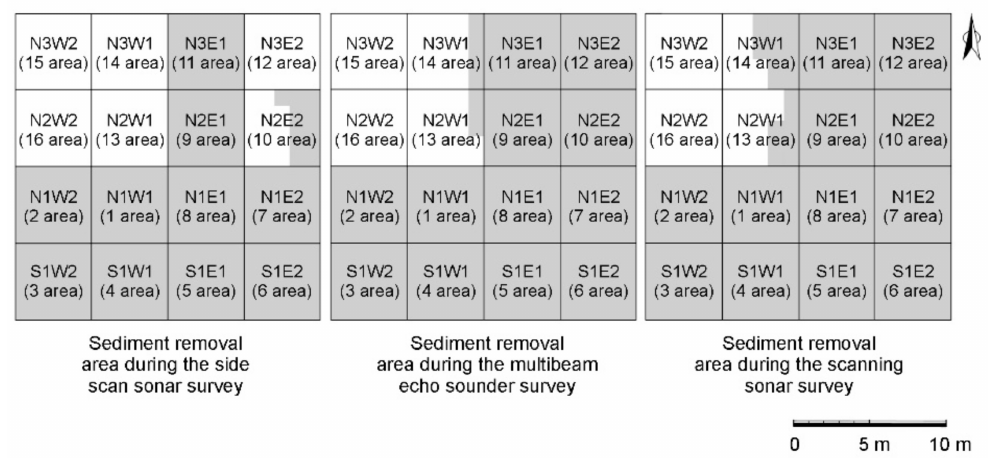
Figure 2. Map codes indicating the geophysical survey sediment removal section at the Dangampo site ( (cid:4) : sediment removal section after the